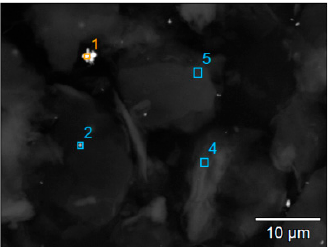
Figure 7. SEM pictures of Pd/GO-A. The content of Pd ranged from 0.28 to 10.20 atom% and the Cl content was 0.18–0.36 atom%.